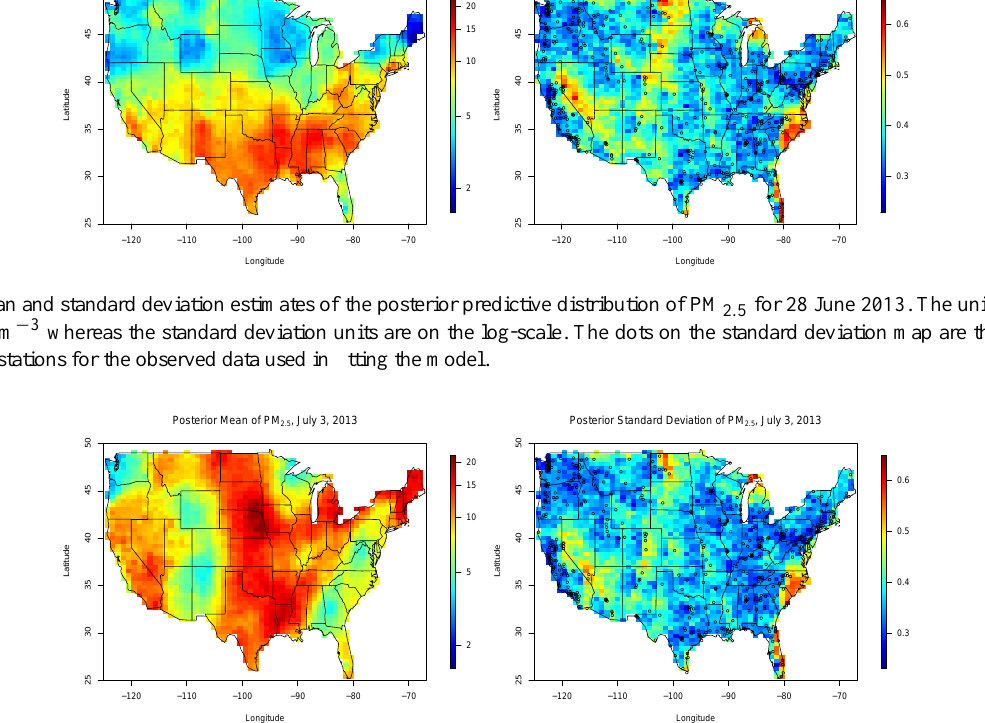
Figure 15. Mean and standard deviation estimates of the posterior predictive distribution of PM 2 . 5 for 3 July 2013. The units of the mean are given in µgm − 3 whereas the standard deviation units are on the log-scale. The dots on the standard deviation map are the locations of the monitoring stations for the observed data used in fitting the model.